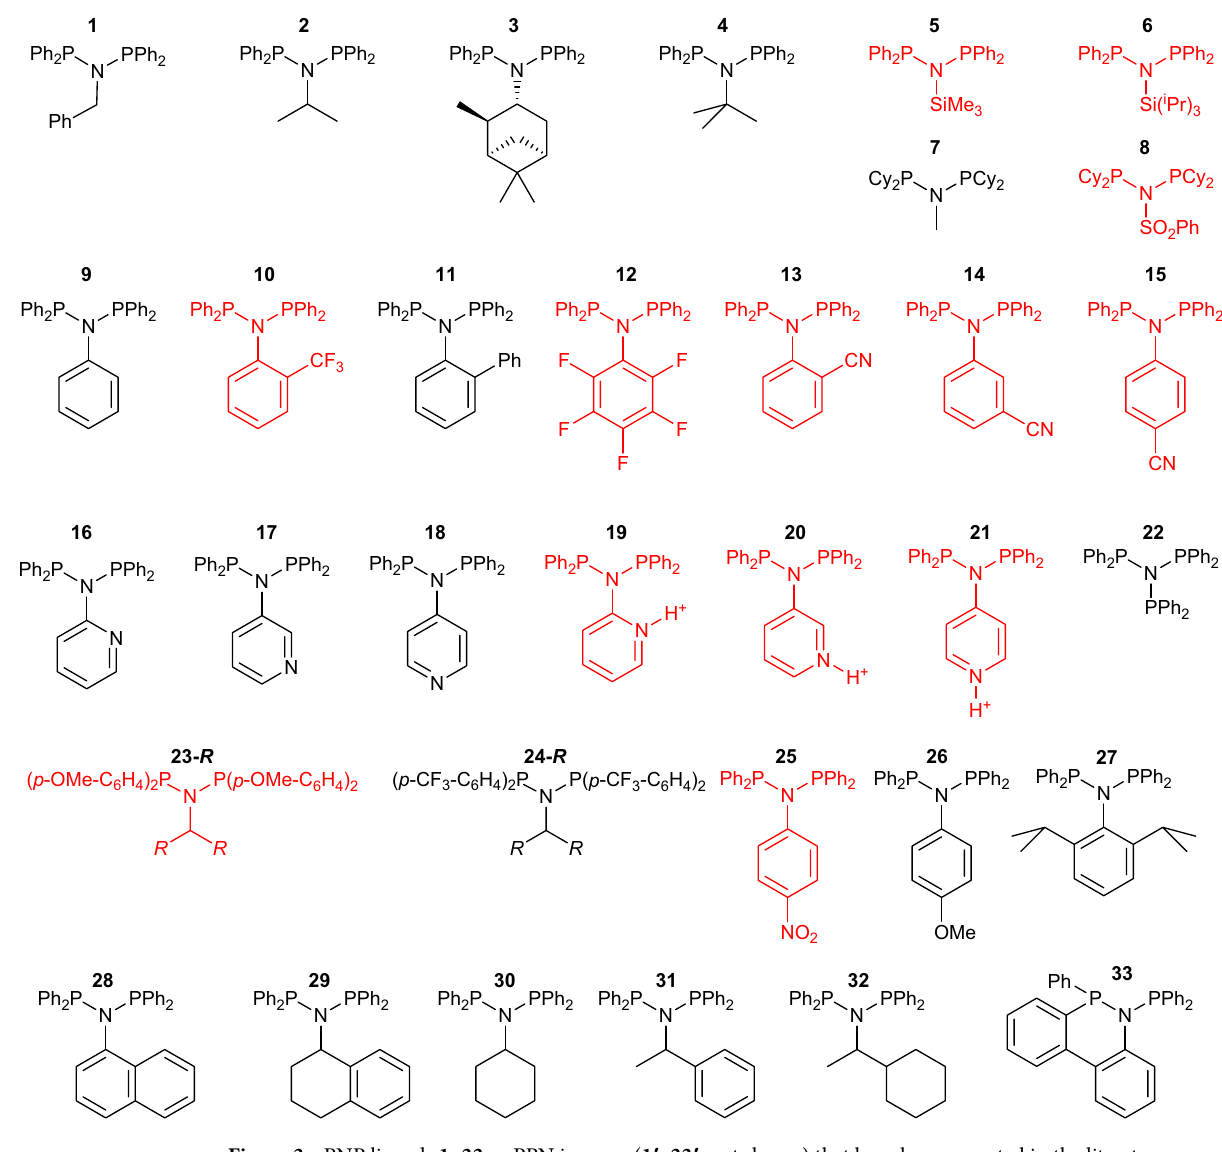
Figure 3. PNP ligands 1 – 33 or PPN isomers ( 1 ′ – 33 ′ , not shown) that have been reported in the literature. Black structures are calculated to have positive ΔG PPN ; red structures have negative ΔG PPN .